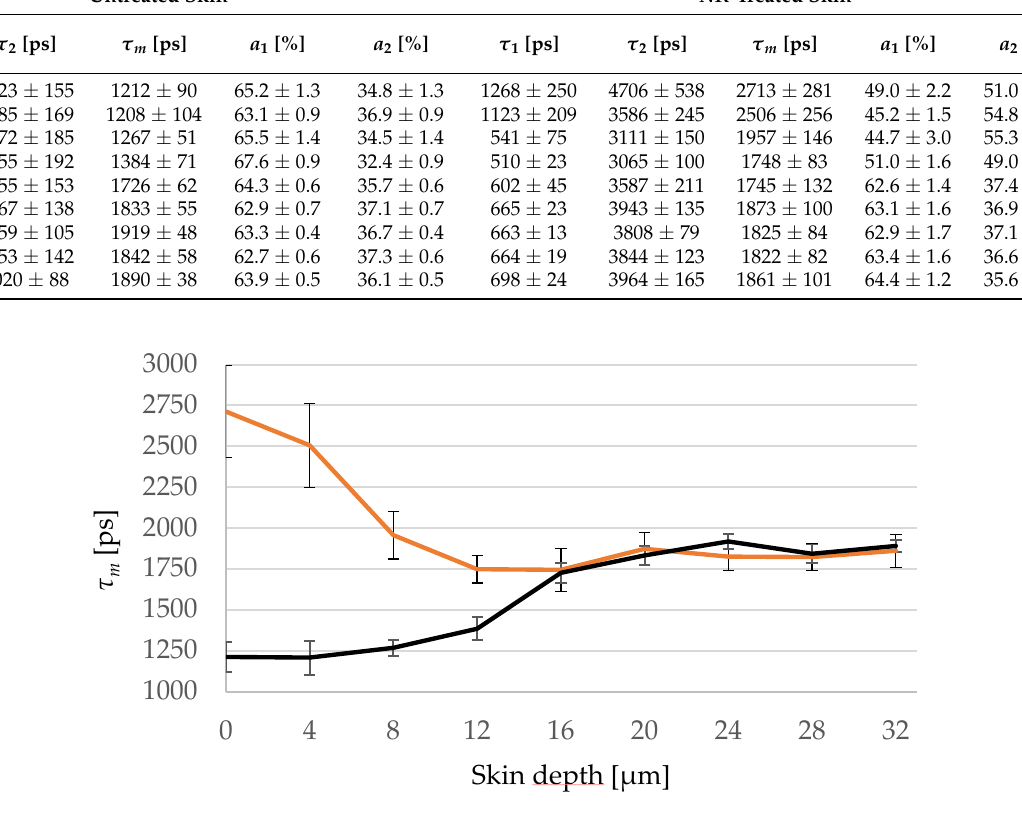
Table 4. TPE-FLIM parameters of untreated and NR -treated skin. Mean ± SEM. N = 6.